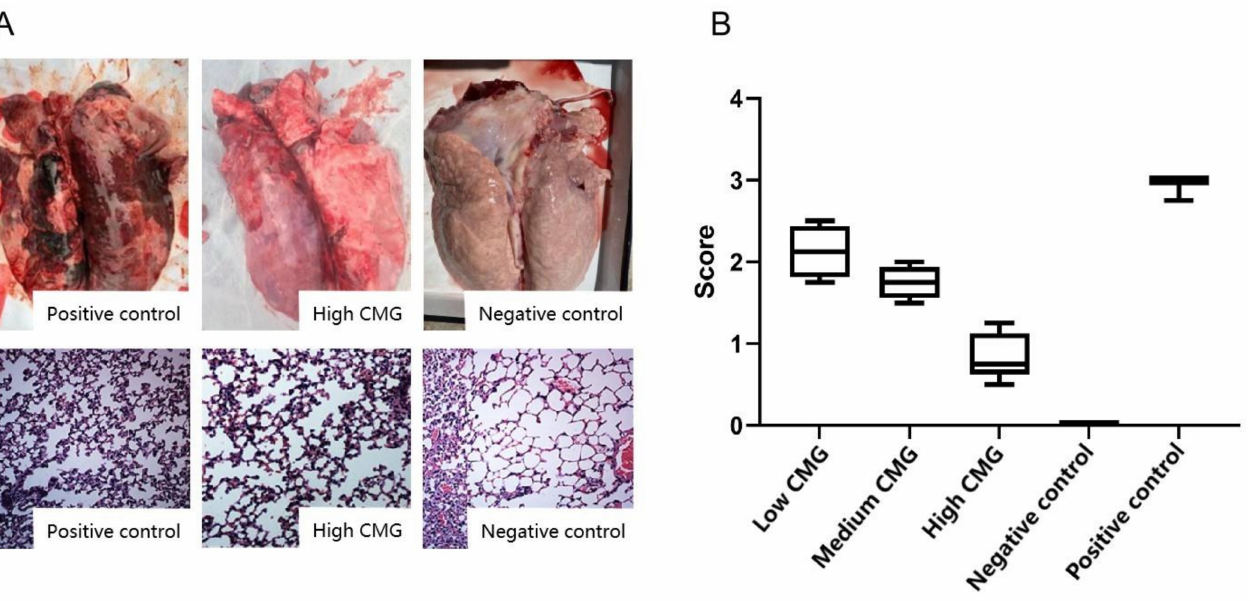
Figure 5. Pathological testing and evaluation. ( A ): lung autopsy analysis and lung histopathological examination results. ( B ): comparison of pathology scores after lung dissection in five groups of